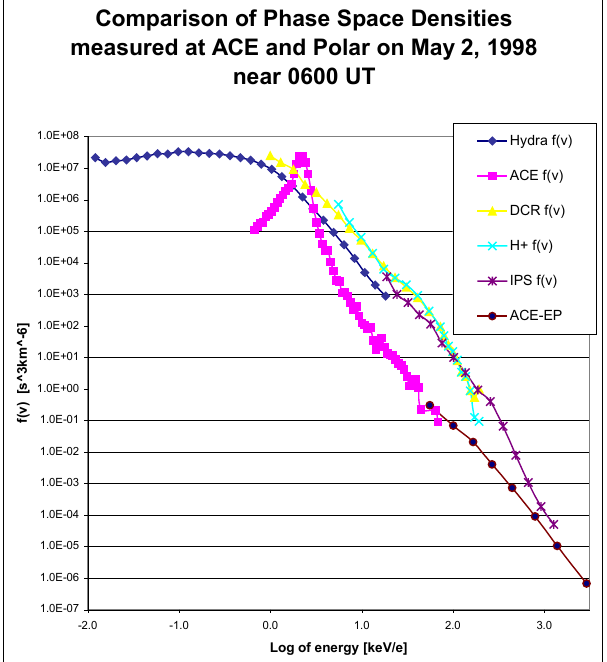
Fig. 13. Same format as Fig. 2 but now the two populations corre- spond to a plasma recorded just before 06:00UT on 2 May at ACE and just after 06:00UT at Polar. Even though the charge state com- parison is not necessarily unique, as in the previous cases, there is still the same general behavior of the two measured plasma popula-